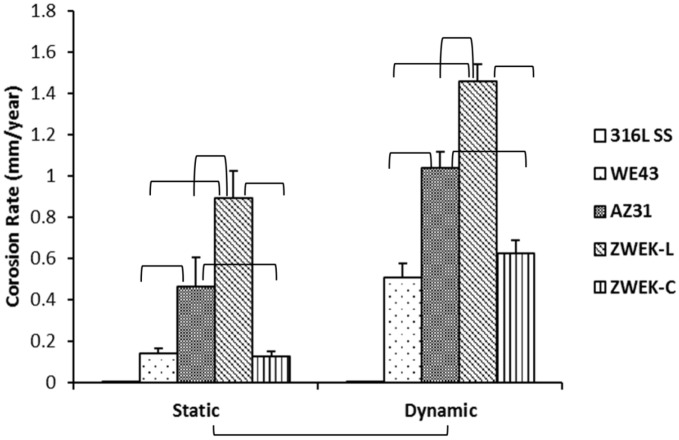
Statistical analysis of corrosion rate of four Mg-based alloys at both static and dynamic conditions.Parenthesis mean significant differences between groups (P<0.05).